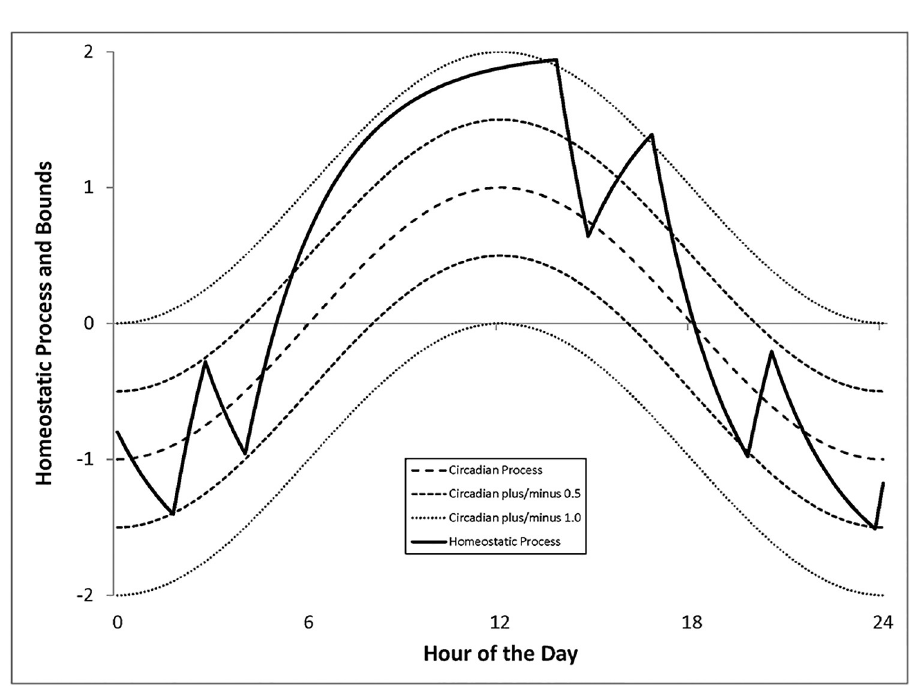
Fig 4. Behavior of the generalized model. Time-varying opportunity cost of sleep.